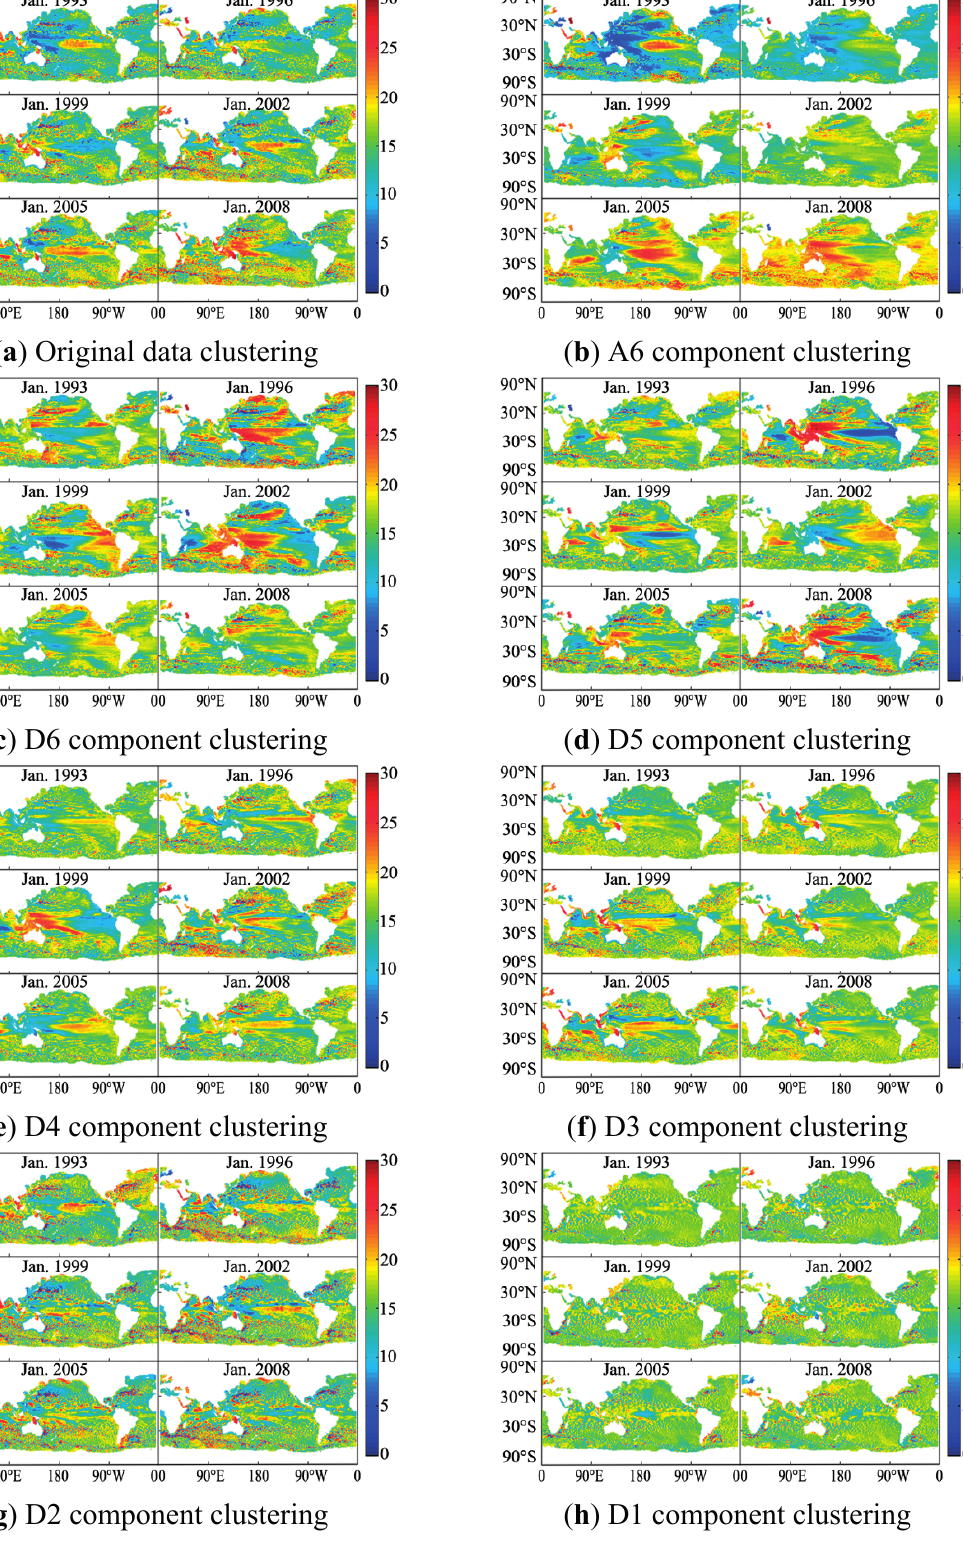
Figure 7. The cluster results of the original data and the decomposed components: ( a ) cluster result of the original data; and ( b – h ) cluster results of A6, D6, D5, D4, D3, D2, and D1 components, respectively. The color bar in each subgraph indicates the classification type index of the data. Due to the space limits, only six time slices are selected for